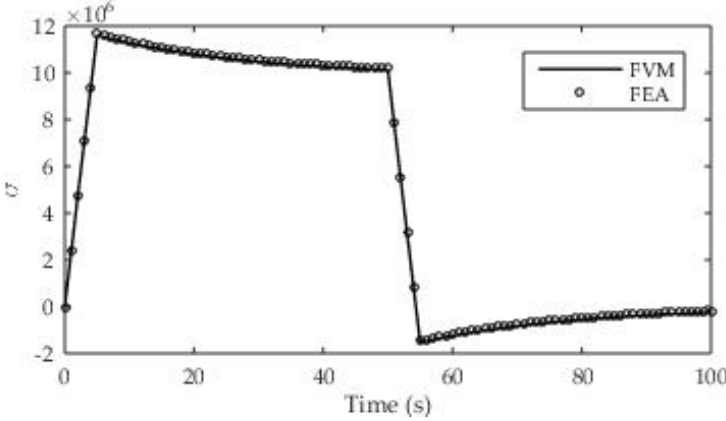
Figure 19. Numerical results for stress relaxation test.